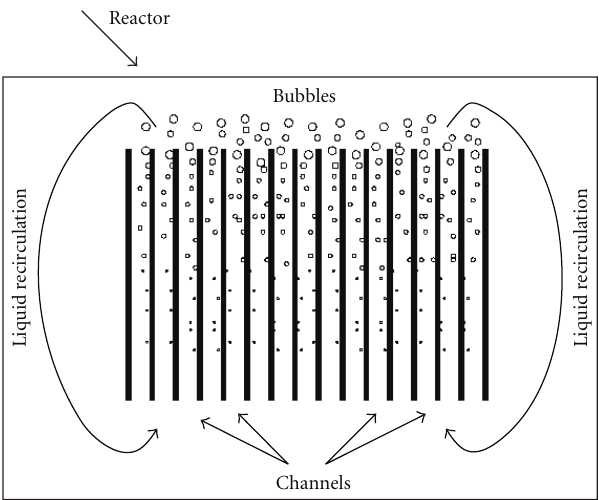
Figure 1: Schematic representation of an electrochemical process. A series of plates (the electrodes) are immersed in a larger container (the